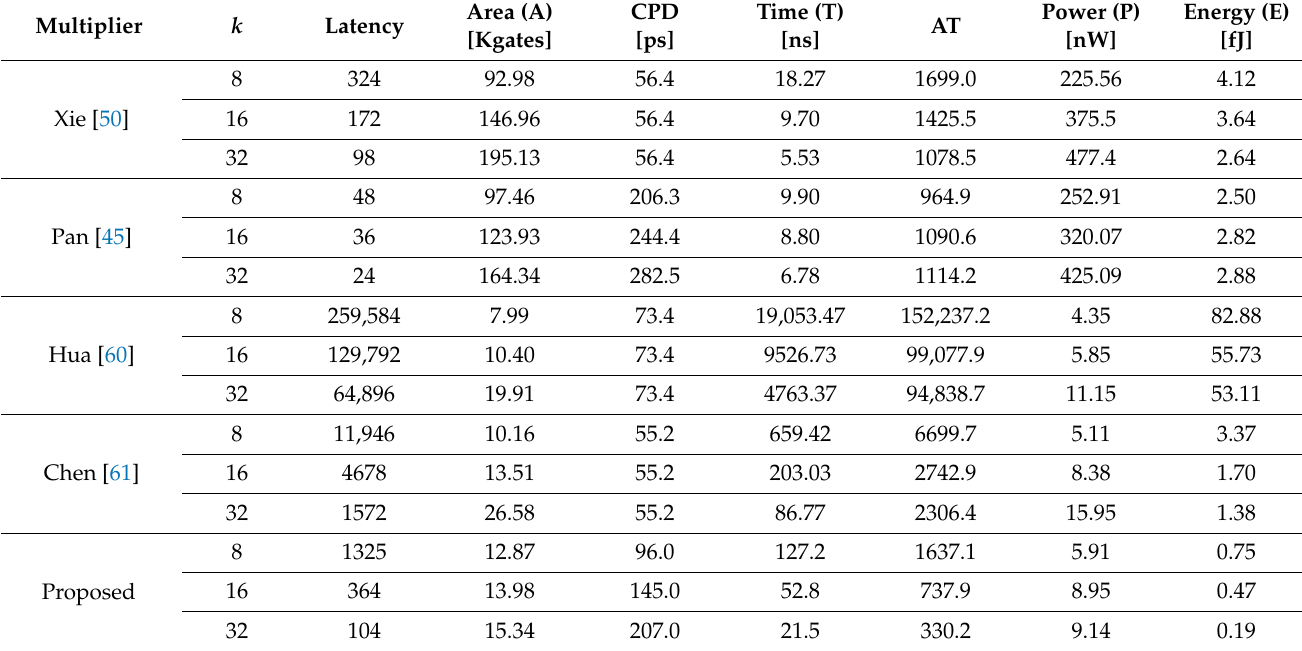
Table 2. Implementation results of different word-serial field multipliers for n = 409 and different values of k . Multiplier